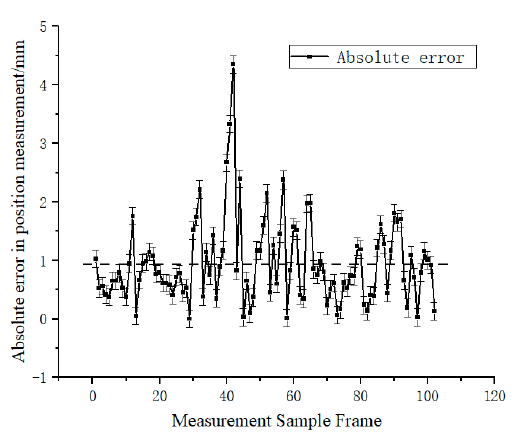
Figure 13. Measurement points Z-directional velocity versus time.